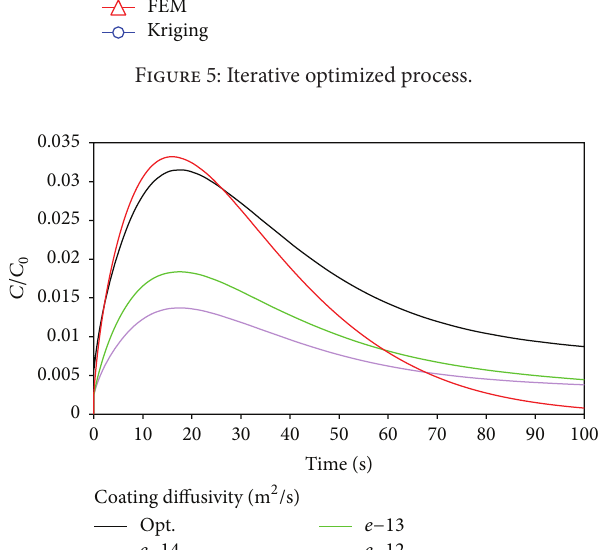
Figure6:Influenceofcoatingdiffusivityondrugconcentrationinto the artery wall.